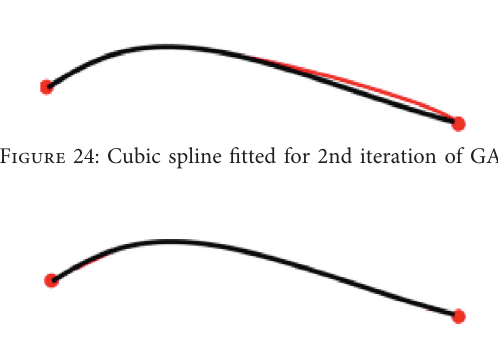
Figure 25: Best optimal curve achieved.